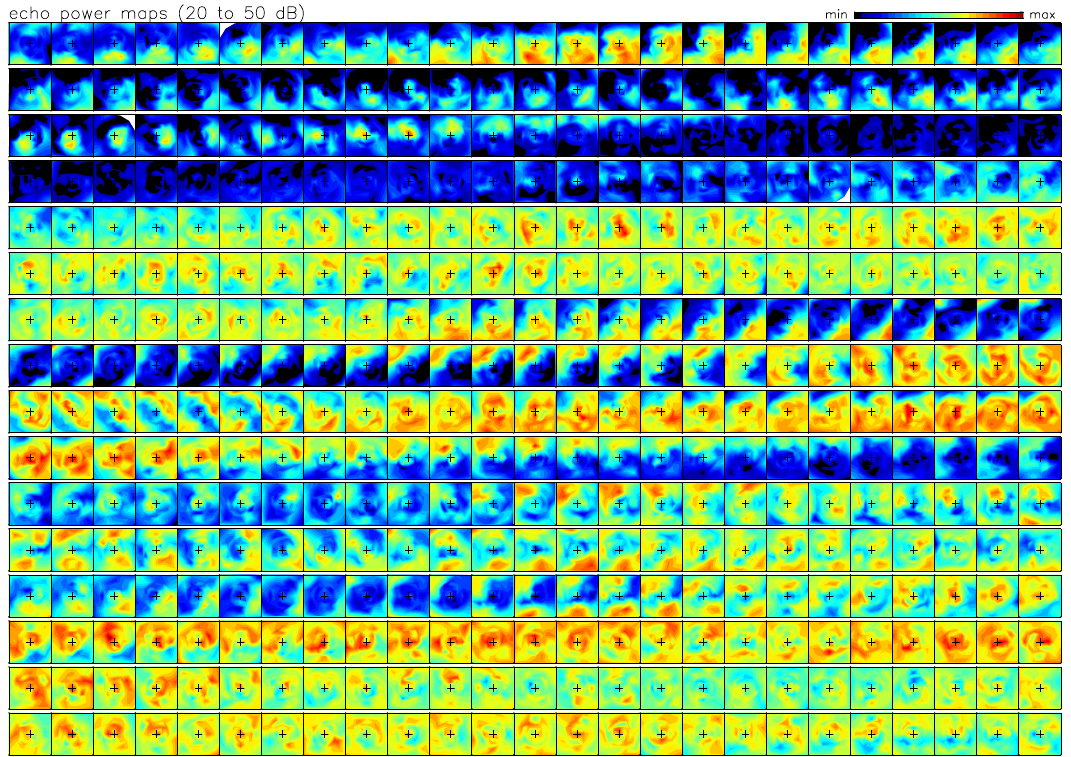
Fig. 5. Horizontal slices of clear-air echo power in rainy conditions, 1.725km AGL, starting 03:37JST 28 February 2002. Time step is 6.55s, north is at the top of each 860 × 860m slice and + marks